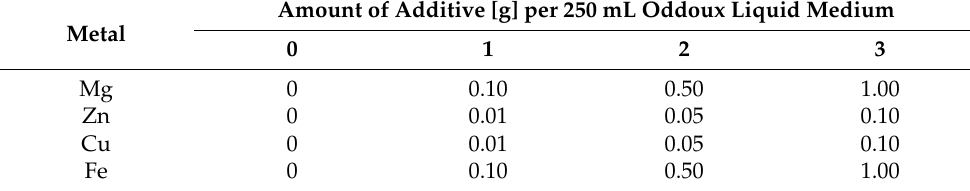
Table 1. Amount of macro- and micronutrients added to the medium used for in vitro cultures of A. bisporus .